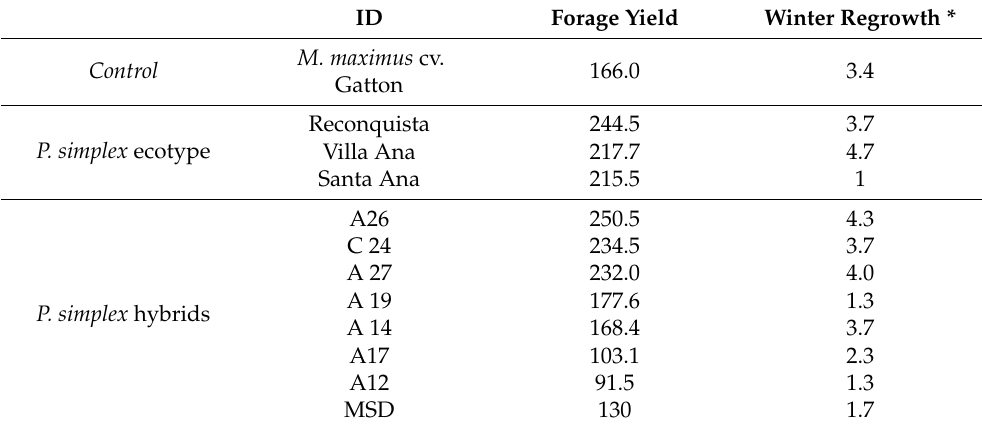
Table 3. Forage yield (g m − 2 ) of a group of P. simplex hybrids and ecotypes, and M. maximus cv. Gatton in Corrientes, Argentina. ID Forage Yield Winter Regrowth